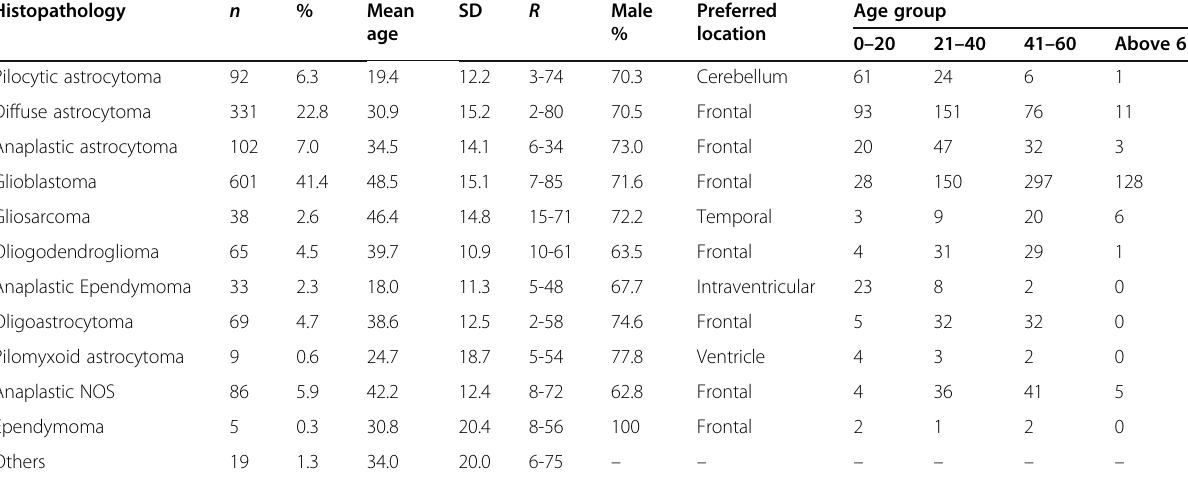
n number of patients, % percentage, SD standard deviation, R